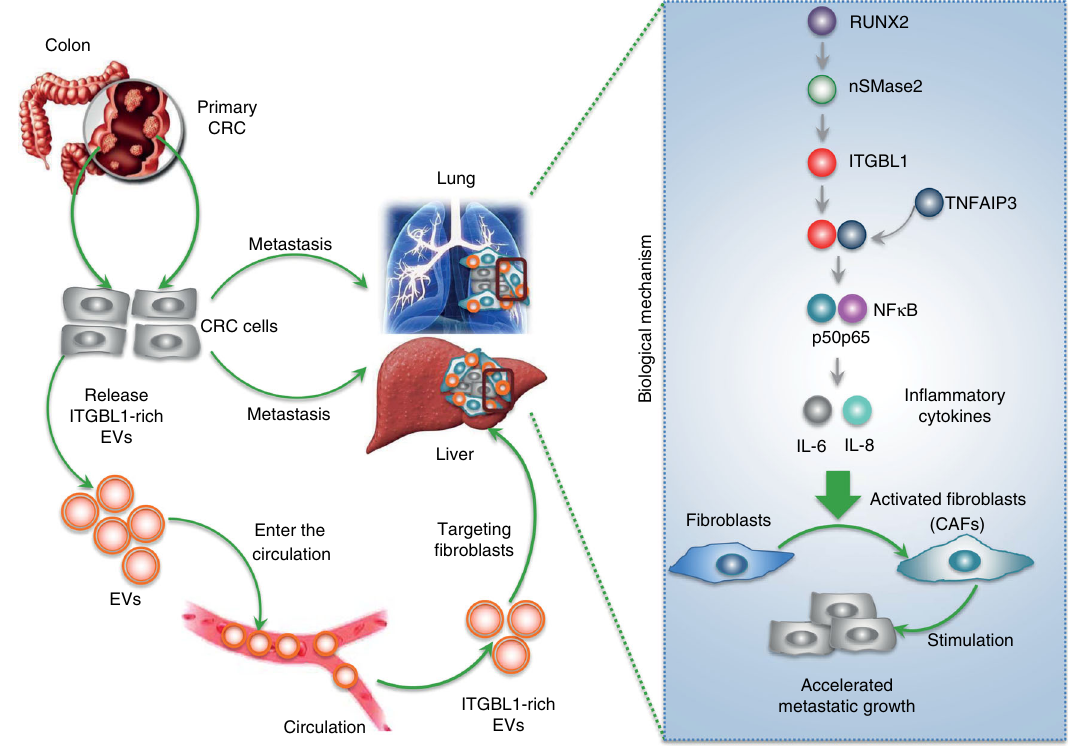
Fig. 9 A schematic mechanism underlying interactions between primary CRC cells and distal fi broblasts through the EVs-mediated transfer of ITGBL1 in promoting the metastasic niche formation in lung and liver. In detail, for biological function description, tumor-derived ITGBL1-enriched EVs convert primary fi broblasts to CAFs via binding to TNFAIP3 and activating the NF- κ B signaling pathway. The ITGBL1-activated CAFs promote CRC stemness, aggressiveness, and EMT by pro-in fl ammatory cytokines, such as IL-6 and IL-8. CAFs manipulated the TME to support metastatic tumor growth. For the molecular mechanism of ITGBL1 secretion, in primary CRC, the transcription of ITGBL1 was regulated by RUNX2, and the secretion of ITGBL1-loaded EVs was elevated by RUNX2 through the ceramide-dependent EVs secretion pathways mediated by at 100,000 × g for 70min. After washing with phosphate-buffered saline (PBS), the pellets were deal with ultracentrifugation (Beckman 70Ti rotor). The EVs quality, size, and particle number were characterized by electron microscopy and LM10 nanoparticle characterization system (NanoSight, Malvern Instruments). All the puri fi ed EVs pellets were resuspended in PBS and the protein concentration was determined by bicinchoninic acid (BCA; Pierce, Thermo Fisher Scienti fi c). Normal EVs from healthy volunteers ’ plasma or normal colonic epithelial cells NCM-460 were also puri fi ed and characterized for the control in our studies. Construction of the expression vectors . Human ITGBL1 , RUNX2 , and nSMase2 genes were ampli fi ed by reverse transcription polymerase chain reaction (RT-PCR) and sub-cloned into the expression vector pcDNA3.1, and were named pcDNA3.1- ITGBL1, pcDNA3.1-RUNX2, and pcDNA3.1-nSMase2, respectively (Supplemen- tary Table 5). The Ubi-Luc-MCS plasmid was purchased for lung and liver and PCR analysis were listed in the Supplementary Table 7. metastases mice models, and in vivo optical imaging. For constructing the ITGBL1 promoter luciferase reporter with or without the RUNX2-binding element − 793 to − 786 (ACCACAAA) relative to the transcription start site (TSS), the ITGBL1 promoter regions − 825 to 36 were ampli fi ed and inserted into the pRF-basic vector, and this was named pRF-ITGBL1 ( − 825/ + 36). pRF-ITGBL1 ( − 825/ + 36) with a mutated RUNX2-binding motif (ACCTCAAA) was constructed for negative control. Cell transfection and lentivirus infection . Transient transfections were per- formed using the Lipofectamine 2000 kit (Invitrogen) according to the manu- facturer ’ s instructions. Recombinant lentiviruses containing pLV4-shRNA- ITGBL1, pLV4-shRNA-RUNX2, pLV4-shRNA-nSMase2, pLV4-shRNA- threitol, and alkylated with 100mM iodoacetamide. Then the samples were pro- teolytic digested with endoproteinase LysC overnight at room temperature, following by digestion with trypsin (Promega) for 15 h at 37 °C. The resulting peptide mixtures were extracted using peptide extract solution (50% ACN (aceto- Luciferase reporter assay . Approximately 8000 HEK293T cells per well or 12,000 LoVo cells per well were plated into 96-well plates and were co-transfected with 50ng of the Fire fl y luciferase reporter and 5 ng of the pRLCMV Renilla luciferase reporter using Lipofectamine 2000 kit (Invitrogen). After incubating for 48 h, the Fire fl y and Renilla luciferase activities were quanti fi ed using a dual-luciferase technical replicates of two Co-IP samples were analyzed using MaxQuant and